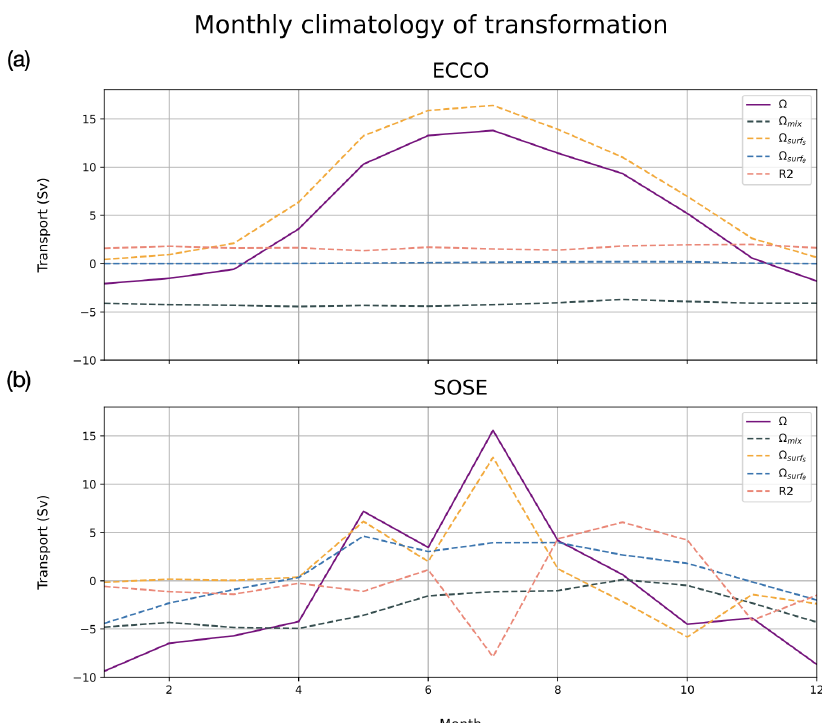
Figure 9. Monthly climatology of Weddell bottom water’s transformation term (purple line) and its sources of transformation: surface salt flux (orange dashed line), surface heat flux (blue dashed line) and mixing (slate-grey dashed line). Residual due to numerical mixing is the pink dashed line in ECCO (a) and SOSE (b)